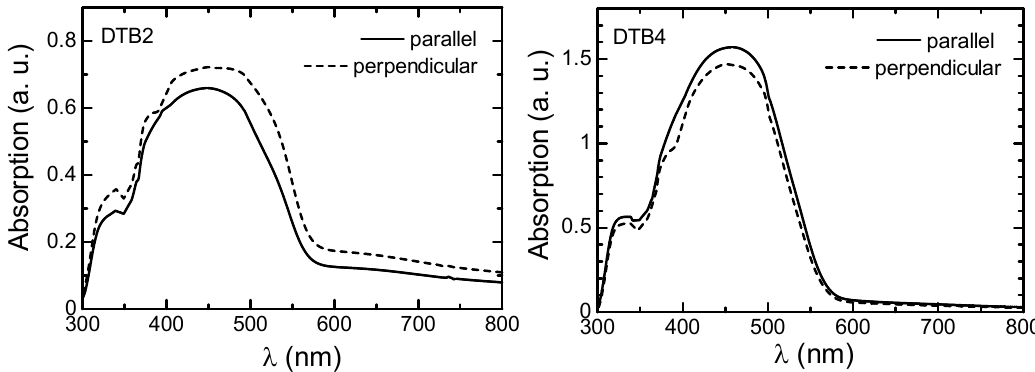
Figure 6. LD UV–vis absorption spectra of polymer films obtained from monomers DTB2 and DTB4. In each spectrum, the solid line indicates the absorption intensity along the direction parallel to the liquid crystal orientation; the dashed line indicates the absorption intensity along the direction perpendicular to the liquid crystal orientation.